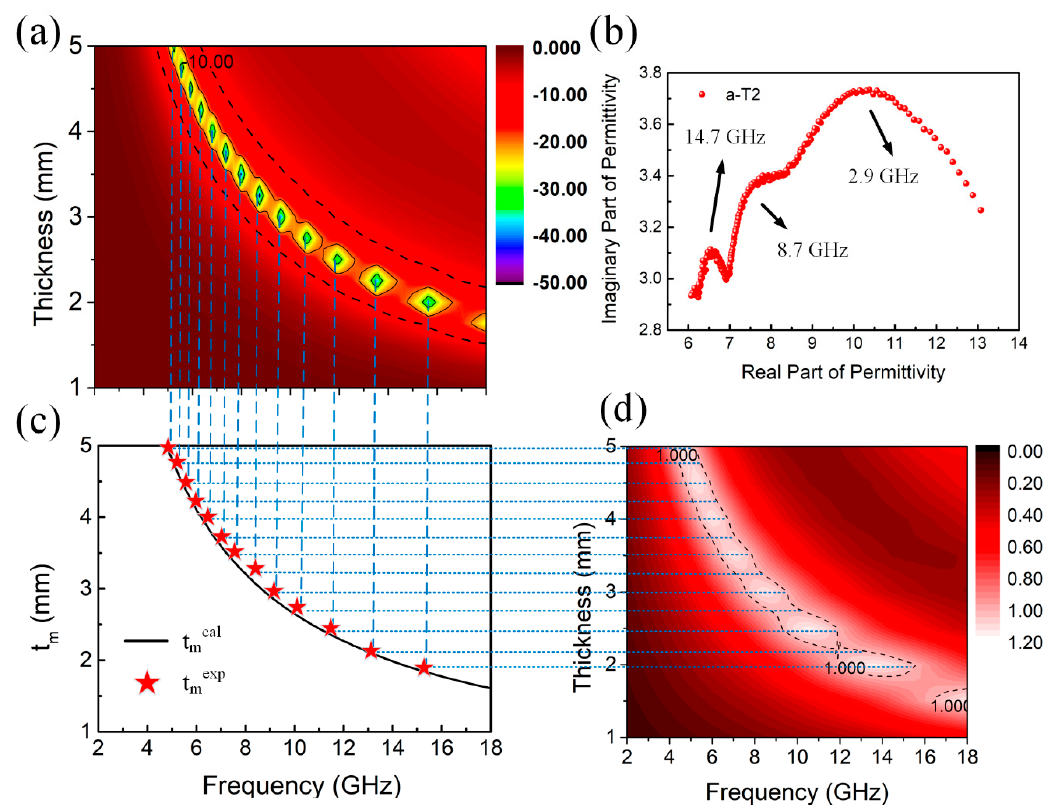
Figure 7. ( a ) 3D Frequency-dependent RL projection plots and ( b ) Cole-Cole plots of a-T2, ( c ) Simulations of the tm versus frequency for a-T2 under the quarter-wavelength matching model. ( d ) 3D Frequency-dependent Z projection plots of